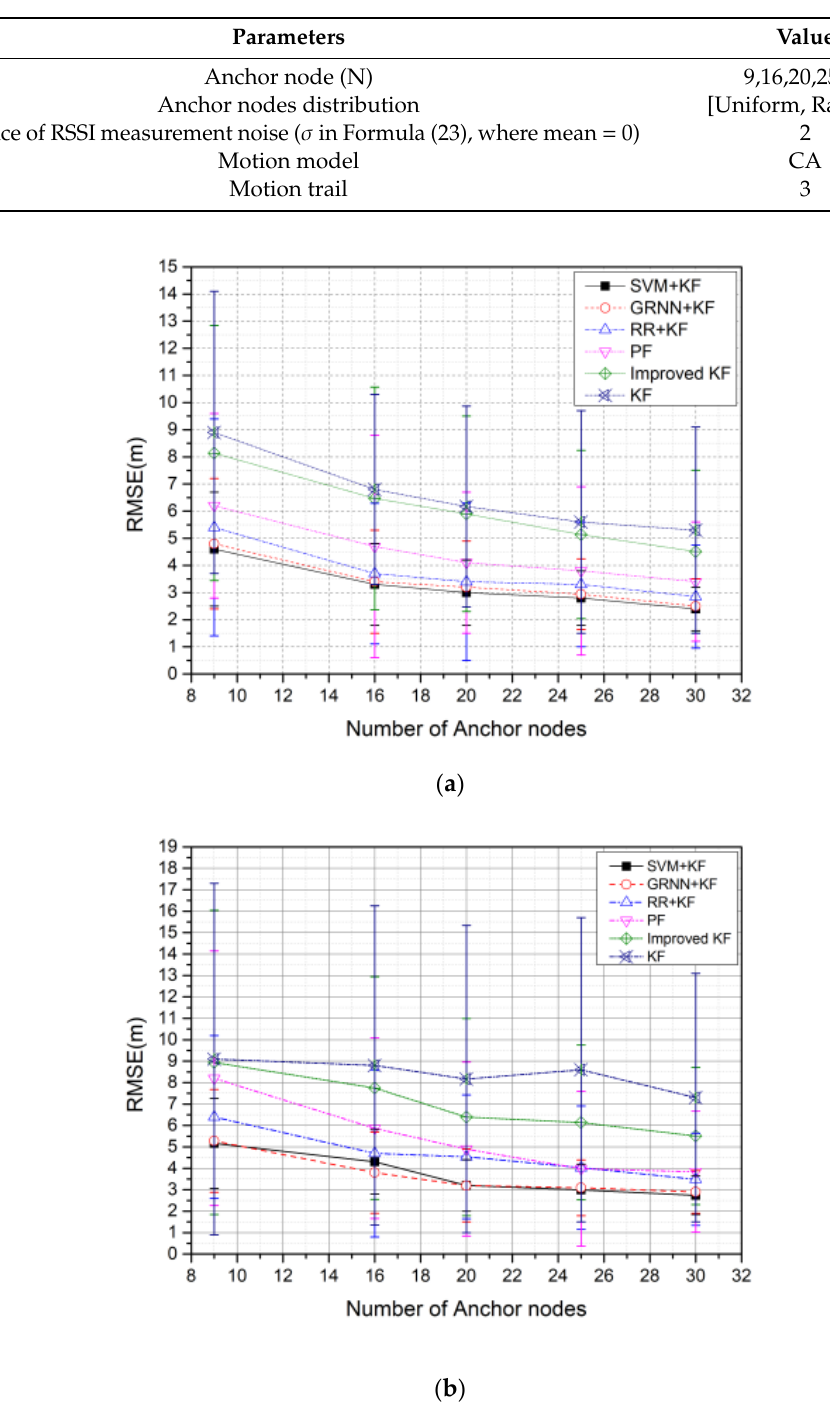
Table 5. Parameter settings.